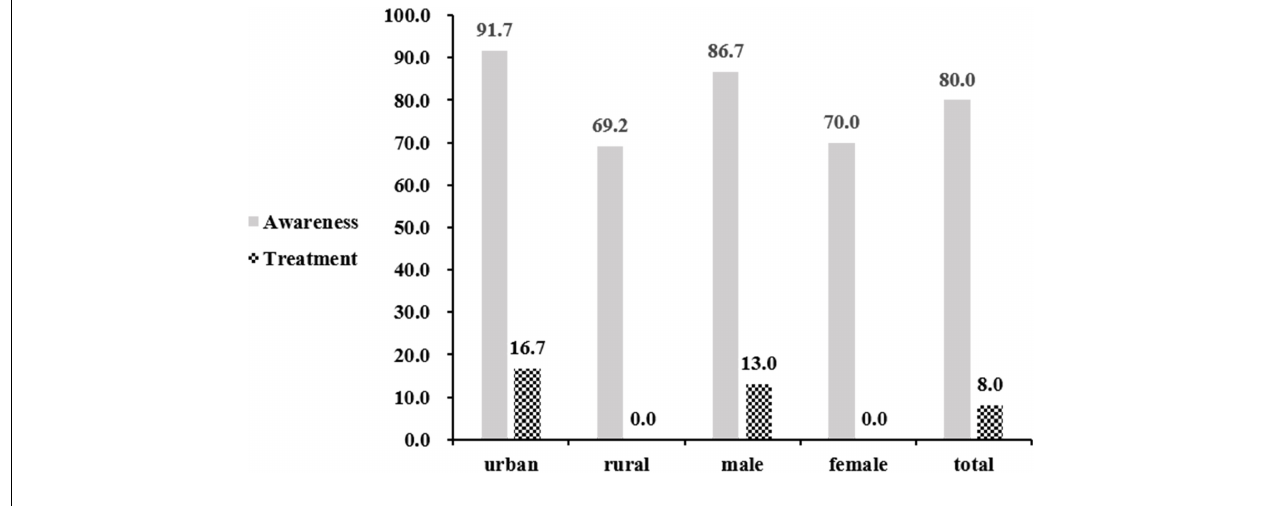
FIGURE 2 | Awareness and treatment of atrial fibrillation (AF). TABLE 3 | Prevalence of some main risk factors in 25 people with atrial fibrillation (AF) in northeast China. Urban Rural Men Women Total P for region P for